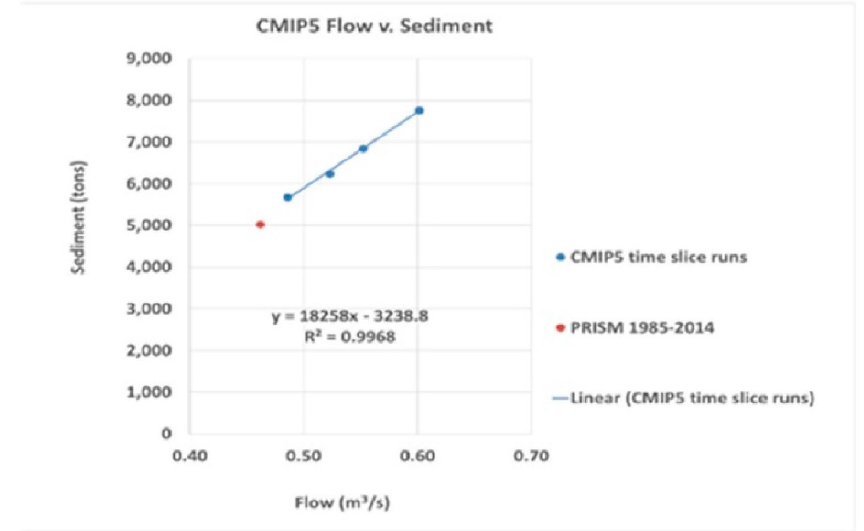
Figure 14. Average of 20 CMIP5 GCMs flow vs. sediment (2018–2100).